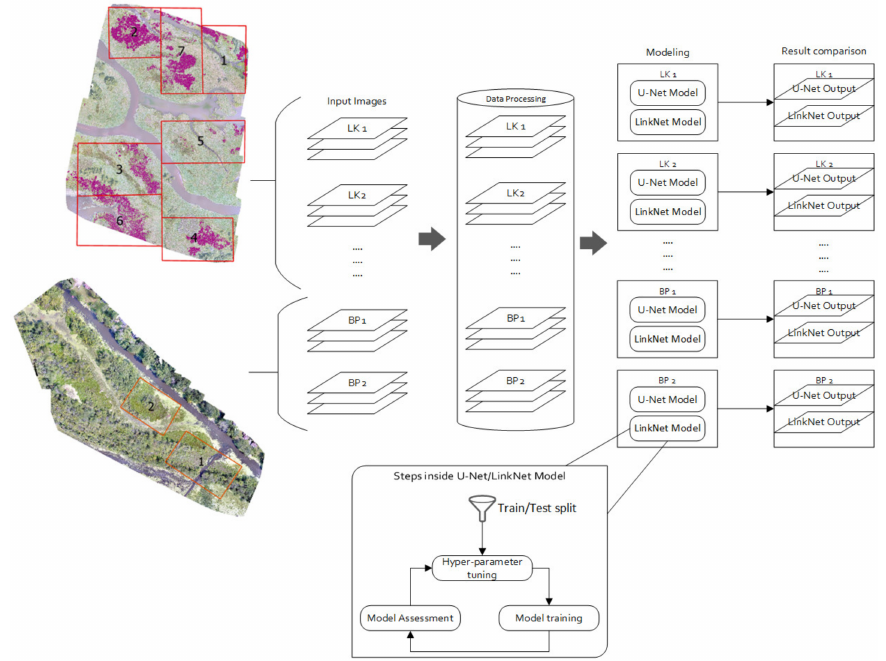
Figure 3. Workflow diagram showing the model implementation in Experiment # 1. The top mosaicked image is from the Lake Neshonoc site and the bottom image is from the Brice Prairie site. The red bounding boxes on each image represent the spatial extent of each subset used for modeling. From the Brice Prairie image ( bottom ), two subsets were used, which are hereafter called BP1 and BP2; from Lake Neshonoc ( top ), seven subsets were used, which are hereafter called LK1, LK2, LK3, . . .